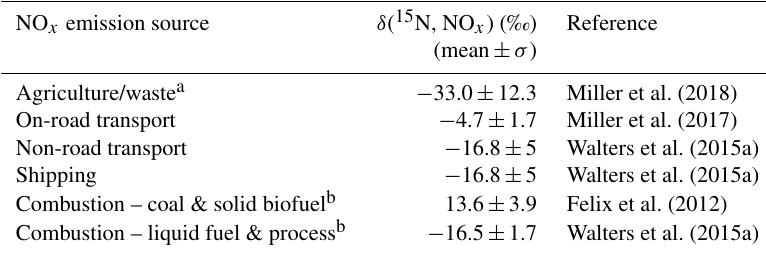
Table 1. Summary of δ ( 15 N, NO x ) emission source